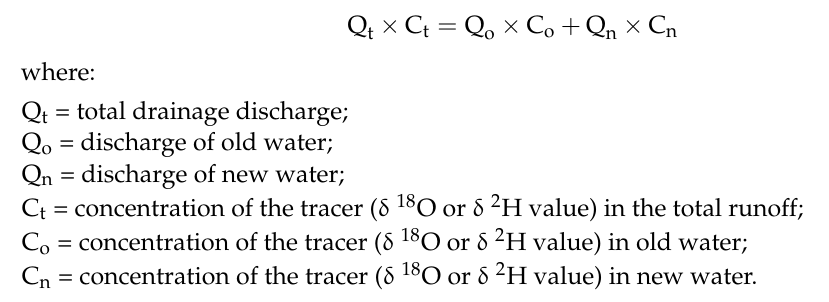
Separation of drainage runoff was calculated at 10 min intervals using